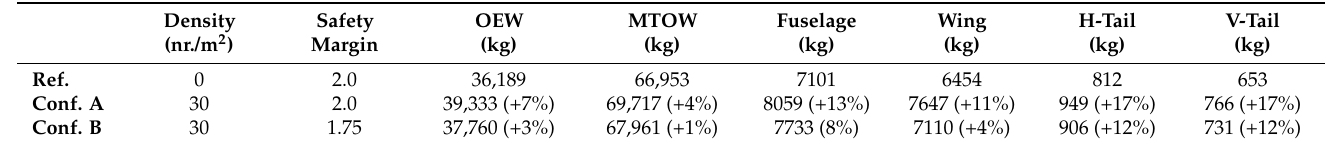
Table 9. Weight comparison for a Conf. B (SM = 1.75 instead of 2.0, thanks to SHM), with respect to Ref. configuration (see [1]) and the new reference, herein, named Conf. A (configuration with SHM, but with SM =